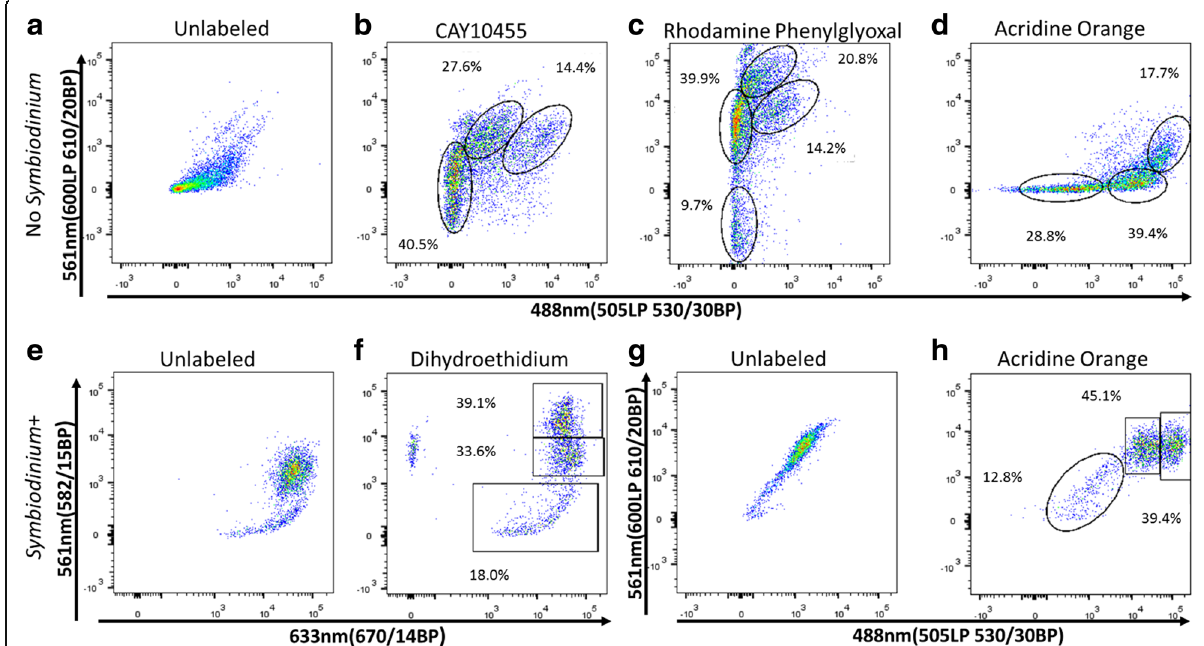
Fig. 3 Examples of cell differentiation from a chemical compound screening. The P. damicornis cell suspension was incubated with the indicated chemical compounds for 30 min at 20 o C and analyzed by FACS LSRFortessa. The analysis was done after differentiation of cells and debris on FSC and SSC and live/dead cells using DAPI, and separated to Symbiodinium positive cells ( e – h ) and Symbiodinium negative cells ( a – d , as shown in Fig. 1). a ) Background control of unstained Symbiodinium negative cells for ( b – d) . b ) Labeled cells with CAY10455, had separation for 3 potential populations shown in gates. c ) Labeled cells with Rhodamine Phenylglyoxal had separation of 4 potential populations. d ) Labeled cells with Acridine Orange had separation of 3 populations shown in red. e ) Background control of unstained Symbiodinium positive cells for ( f) . f ) Labeled cells with Dihydroethidium had separation of 3 populations positive to Symbiodinium . g ) Background control of unstained Symbiodinium positive cells for ( h ). h ) Labeled cells with Acridine Orange had separation of 3 populations positive to